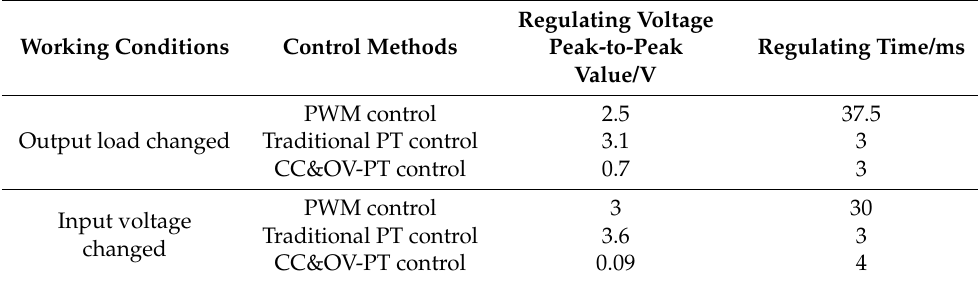
Table 3. The regulation time and peak-to-peak values of system output voltage under different control methods and abrupt changes in different working conditions.